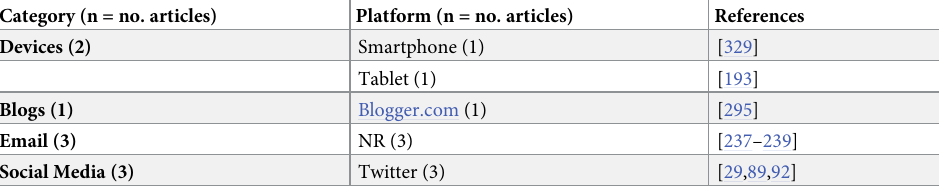
Table 19. Number of articles predicting language, with associated platforms and